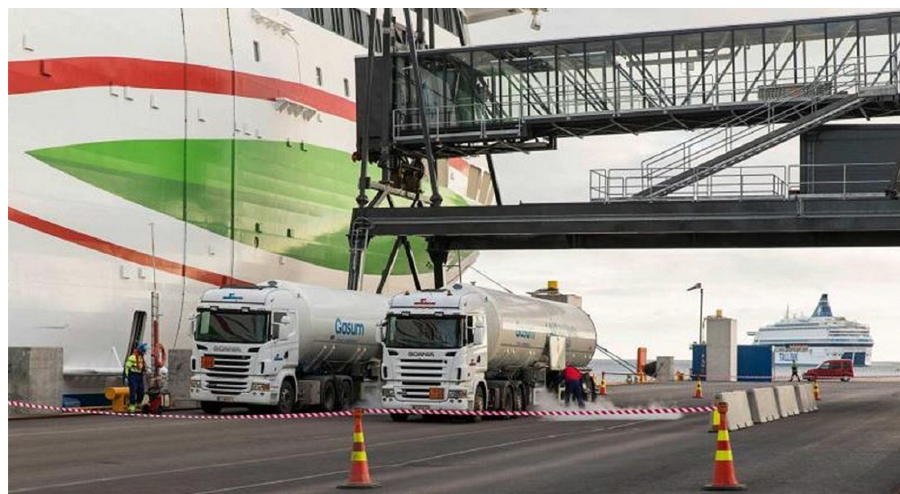
Figure 7. Truck-to-ship bunkering in the Port of Helsinki.